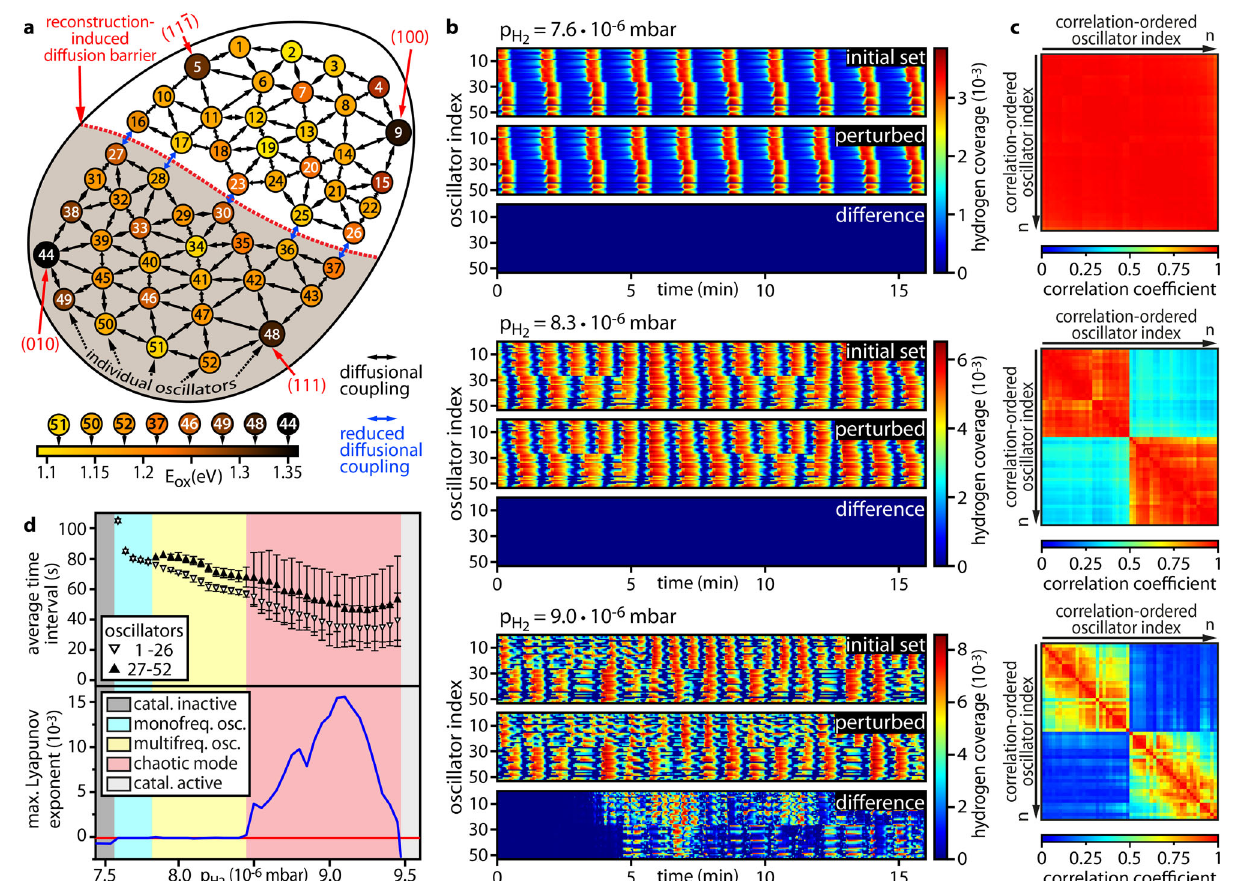
Fig.4|Micro-kineticmodellingofthereactionona2D-oscillatorgrid.a Layout of the oscillator grid based on the surface crystallography shown in Fig. 1. Num- bered individual oscillators are coloured according to their activation energy for subsurface oxygen formation. Oscillators are coupled via hydrogen diffusion, indicated by double arrows. The red dotted line represents the diffusion barrier. b Calculatedtimeseriesofthelocalhydrogencoveragesforeachoscillatorat453K and constant p O2 =4.4×10 − 6 mbar and p H2 =7.6×10 − 6 mbar (top); p H2 =8.3×10 − 6 mbar(middle)¸ p H2 =9.0×10 − 6 mbar(bottom).Thelowerstripsineachpanelshow the difference between the timeseries calculated for the set of initial conditions